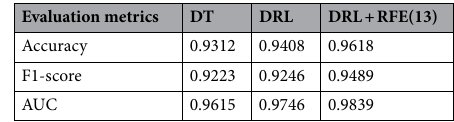
Table 5. Results of DRL with the selected features.